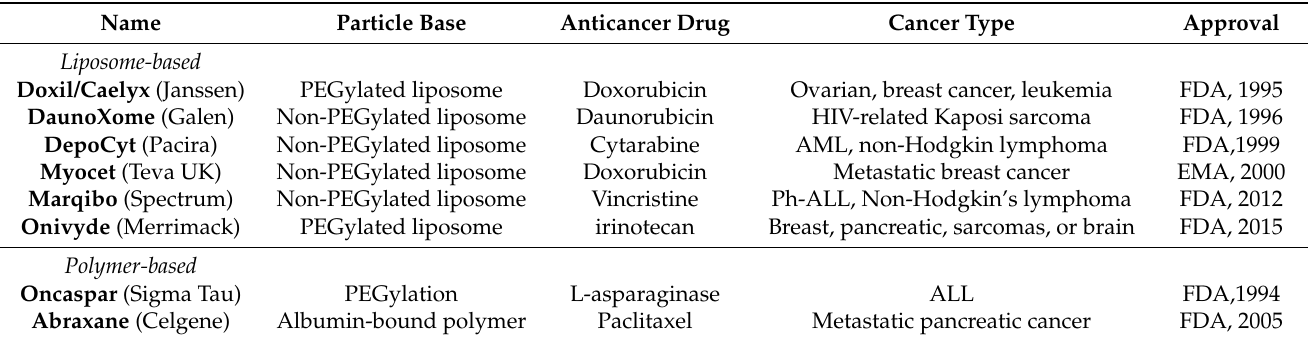
Table 4. Nanotherapeutics approved for oncological